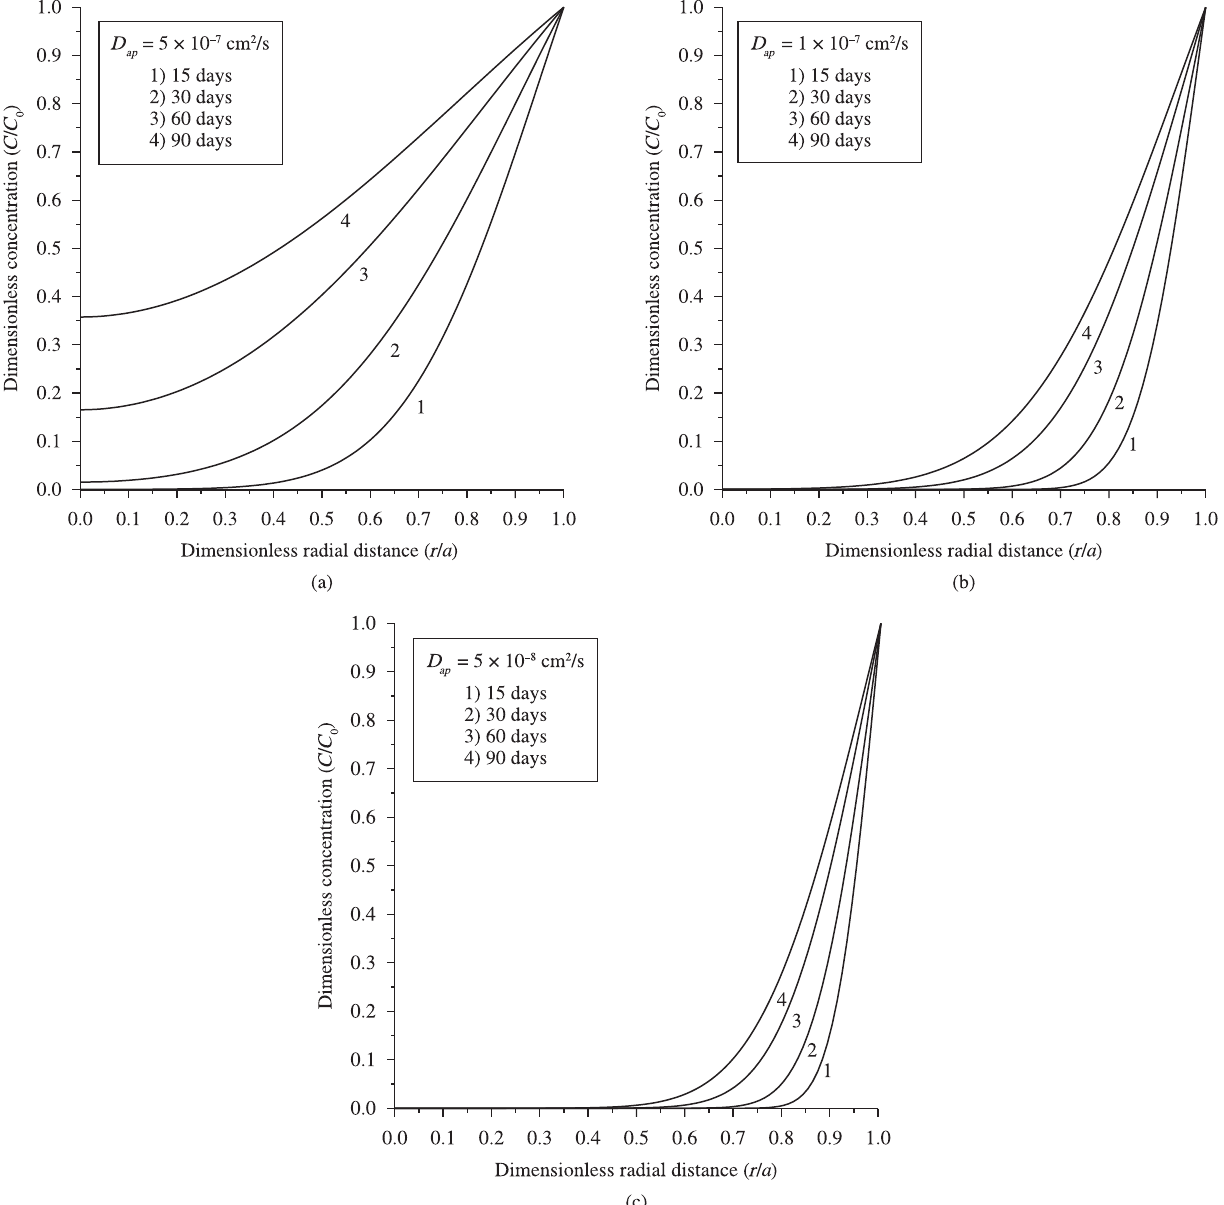
Figure 1. Simulated chloride concentrations distribution in the cylinder for short term exposure to chloride and typical values of apparent diffusivity (using Equation 3): a) D = 5 × 10 –7 cm 2 /s; b) D = 1 × 10 –7 cm 2 /s; and c) D = 5 × 10 –8 cm 2 ap ap ap